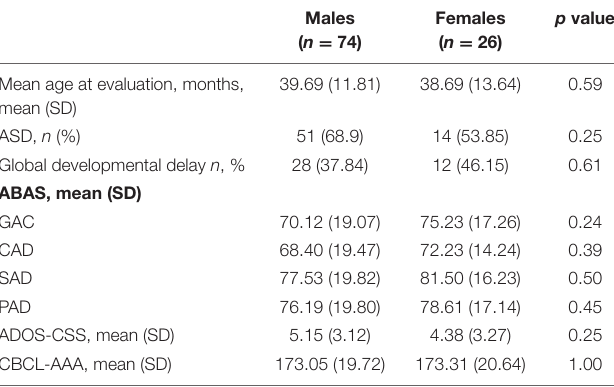
TABLE 2 | Sample characteristics by sex ( n = 100).